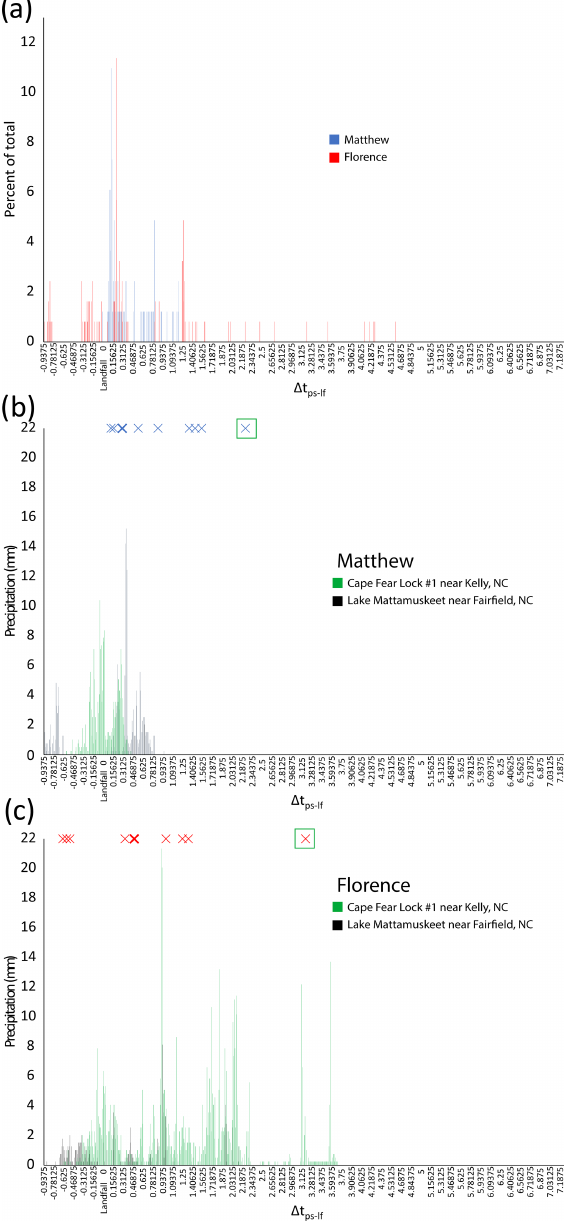
Figure 3. Time evolution of surge, rainfall, and river flooding dur- ing hurricanes Matthew and Florence in North Carolina. X axis is (cid:49)t ps-lf binned in 15min increments (unit days) and covers approx- imately 1d prior to landfall to 7d after. (a) Percent of peak surge occurrences; blue is for Matthew, and red is for Florence. Panels (b) and (c) display precipitation (mm) and initial fluvial flooding in the same 15min increments during Matthew and Florence respec- tively. Green bars represent precipitation recorded at the Cape Fear Lock #1 rain gauge near Kelly, NC, and black bars represent pre- cipitation recorded at the Lake Mattamuskeet rain gauge near Fair- field, NC. Crosses indicate when river gauges in the study area first reached minor flood stage. Bold crosses represent two river gauges reaching minor flood stage in the same 15min increment. Cross bounded by green square is the river gauge co-located with the Cape Fear Lock #1 rain gauge.